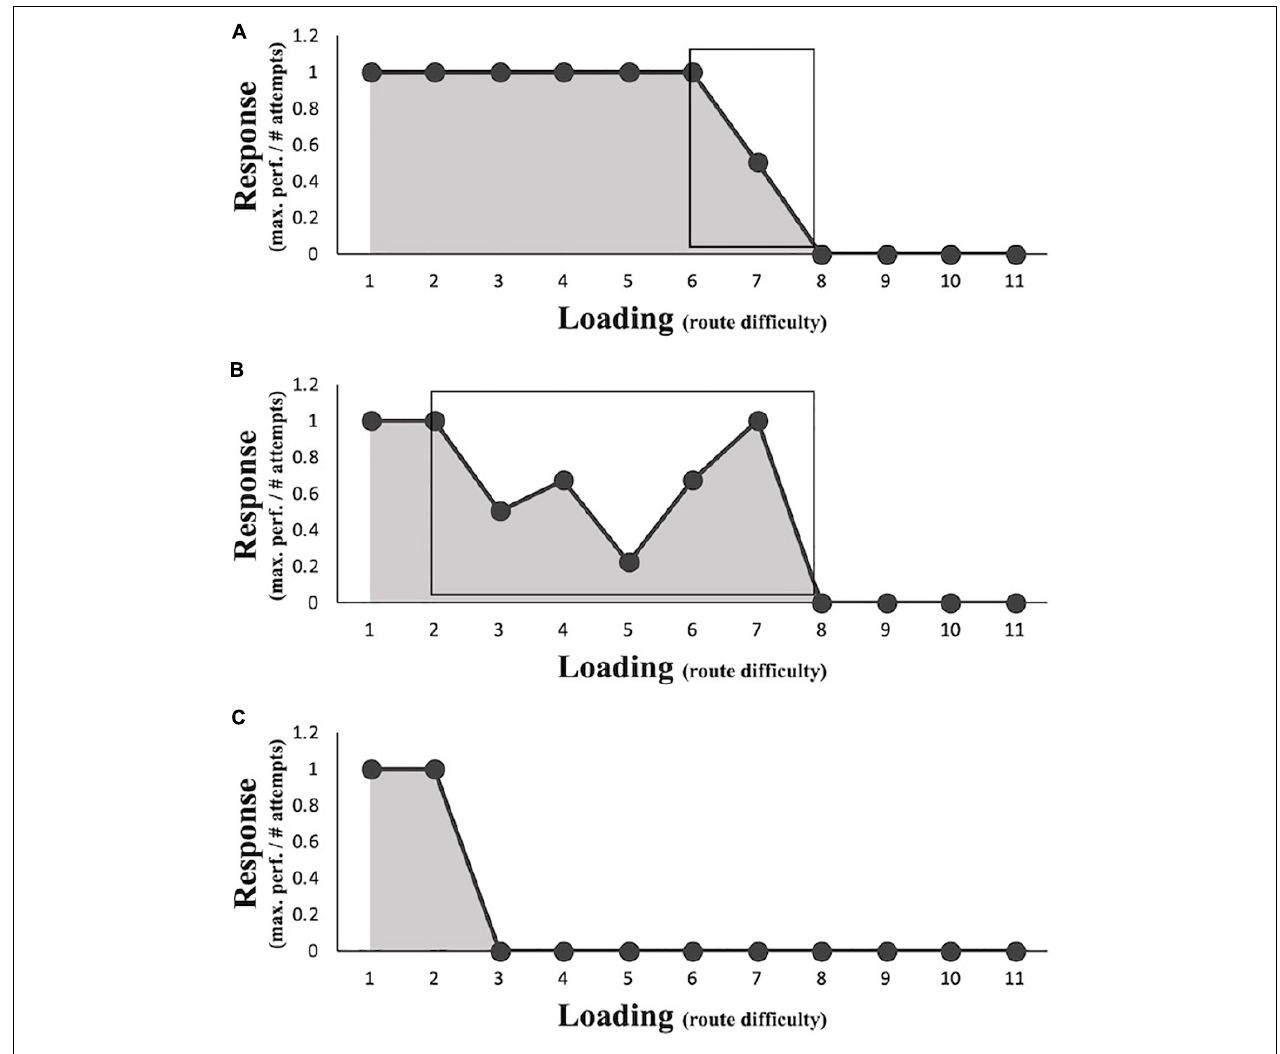
FIGURE 5 | Three examples of load–response profiles for training recommendations. The black rectangles (A,B) represent the recommended training area residing between easy and too difficult routes. The athlete represented in (C) only demonstrates easy and difficult routes with no pattern in between.